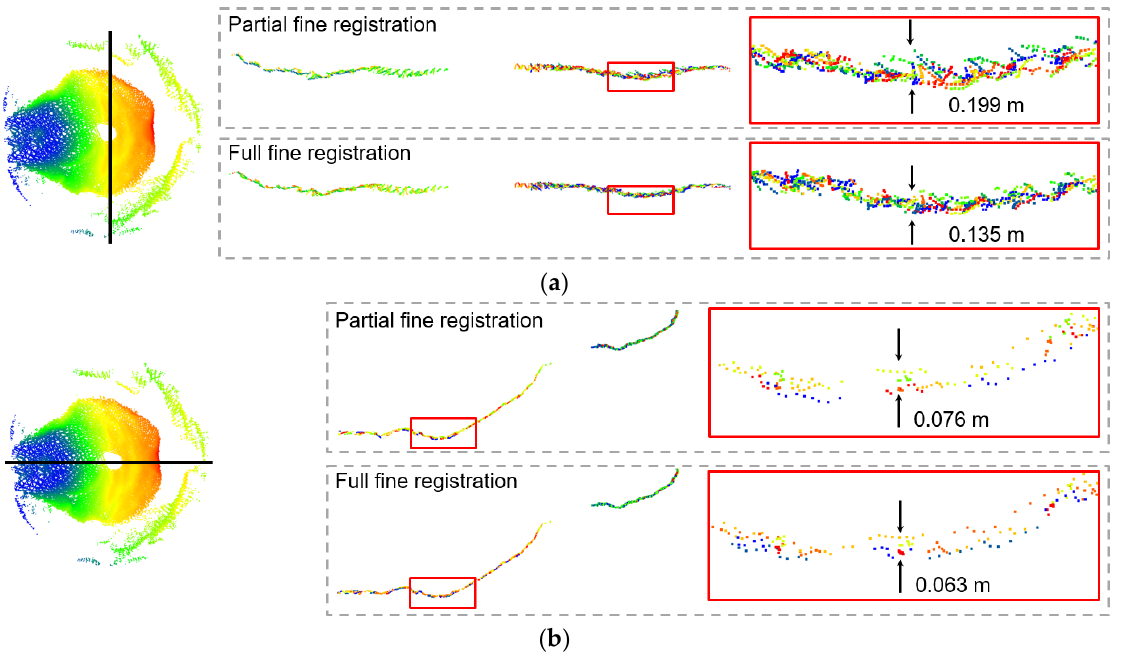
Figure 34. Extracted vertical profiles (width: 0.2 m) through the salt surface of the Lebanon dataset before/after full fine registration (the arrows indicate the direction of the measured distance): ( a ) profile orthogonal to the entrance walls and ( b ) profile parallel to the entrance walls.